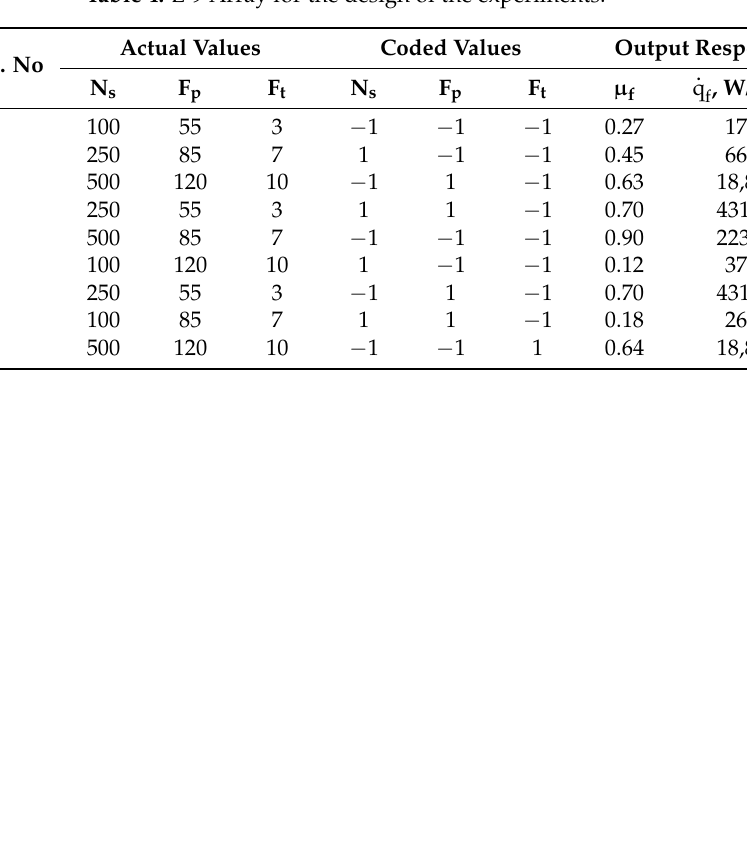
Figure 5. Input and output parameters of the friction welding process.